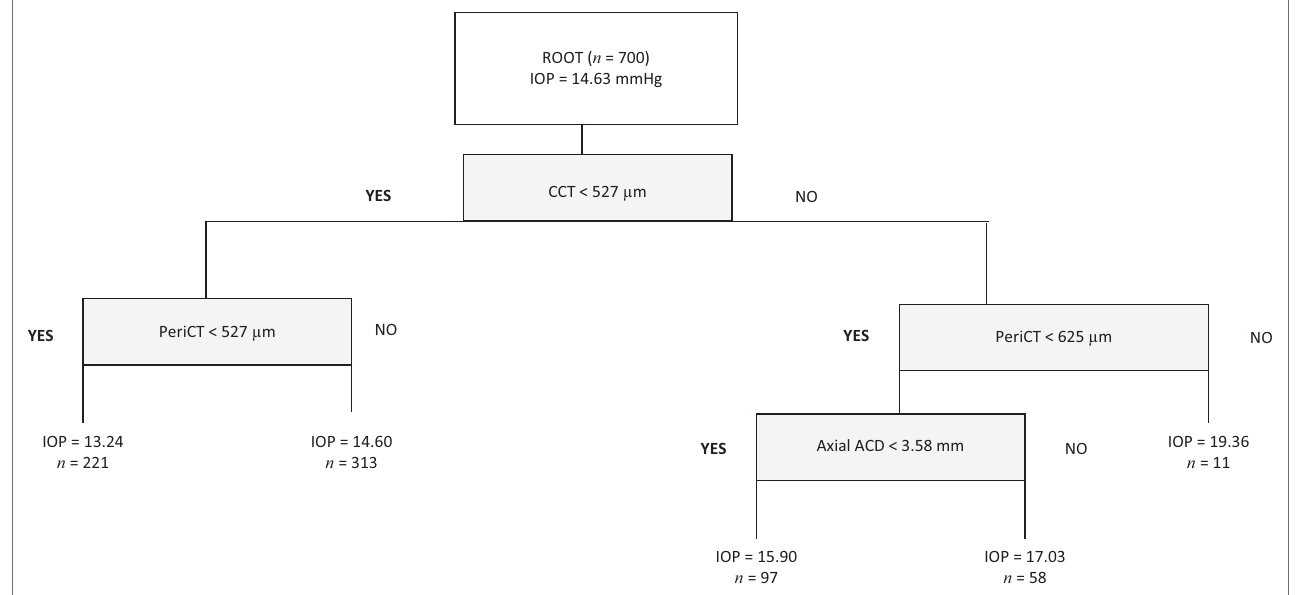
FIGURE 3: Unpruned regression tree model, automatically generated by the classification and regression tree method, for prediction of intraocular